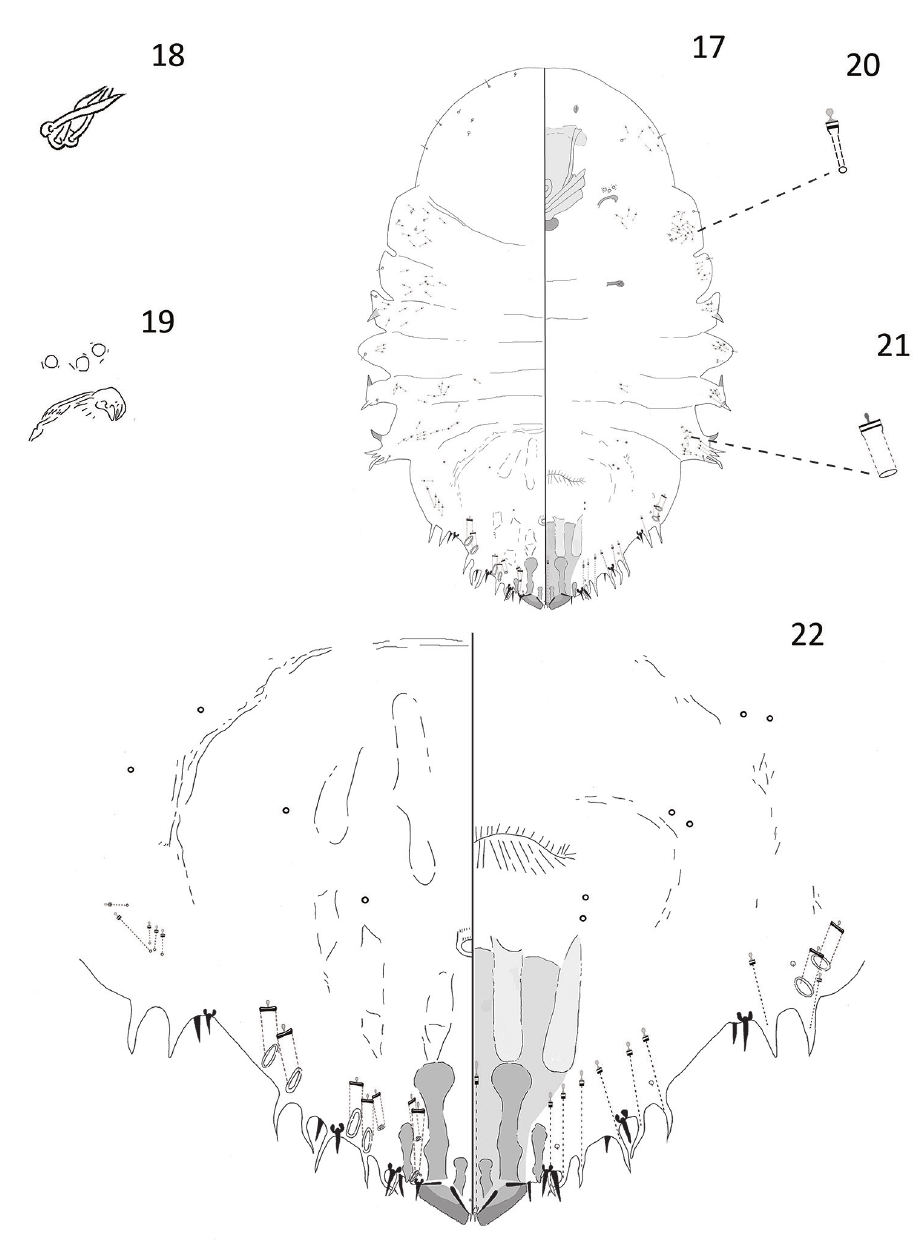
Figure 17–22. Andaspis novaecaledoniae Hamilton and Williams, sp. n., adult female; 17 whole body 18 antenna 19 anterior spiracle 20 microduct 21 macroduct 22